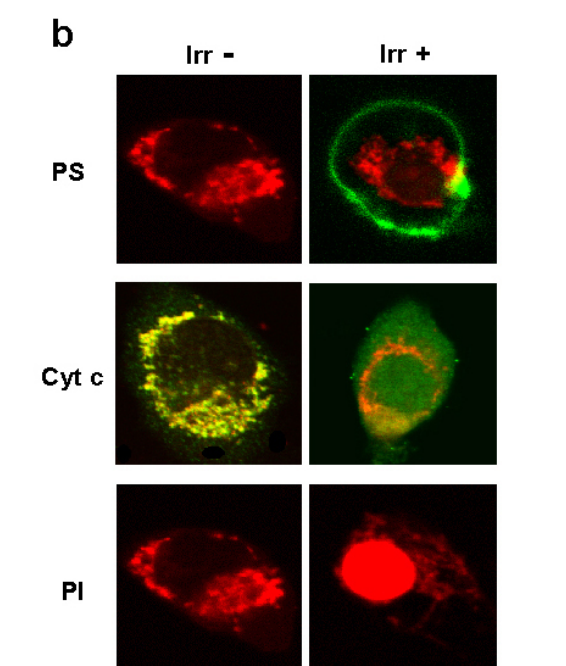
FIGURE 3 . Mitochondrial dysfunction and death outcome following partial irradiation of various proportions of mitochondria irradiated in individual cells. (a) Proportion of cells showing immediate ∆Ψ m loss in nonirradiated mitochondria of CMXRos-loaded cells following partial irradiation as detected by Rh123 (10 µ M) and apoptotic outcomes as indicated by phosphatidylserine (PS) exposure, cyt c release, and lack of propidium iodide (PI) uptake. Quantification of the mitochondria irradiated was carried out as described in the Methods section. Loss of ∆Ψ m was determined as in Fig. 2c. Other imaging aspects are detailed in the caption to Fig. 3b. Data for PS exposure, cyt c release, and PI uptake were collected at 45 min-2 h postirradiation. The number of cells analyzed in each category is indicated on top of the bars. An asterisk (*) reflects artifactual loss of cyt c immunostaining (see text). (b) Representative overlay confocal images showing control cells nonirradiated (Irr-; left column) and partially irradiated cells (Irr+; right column) with a death outcome. Cells loaded with CMXRos (red) were stained with either annexin V-Alexa Fluor 488 (green; top row) to detect PS exposure, anti-cyt c antibody coupled to Alexa Fluor 488 (green; middle row) to detect cyt c release or PI (red; bottom row) for determining plasma membrane integrity. Colocalization of red with green appears yellow. PS exposure detected by Annexin V binding to plasma membrane is depicted by a green ring (top right image). Cyt c release is characterized by diffuse cyt c fluorescence (green) in the whole cell (middle right image). Irradiated cells with permeabilized plasma membrane show red nuclear staining of PI (bottom right), indicating necrosis; the majority of irradiated cells are apoptotic and appear as in the bottom left